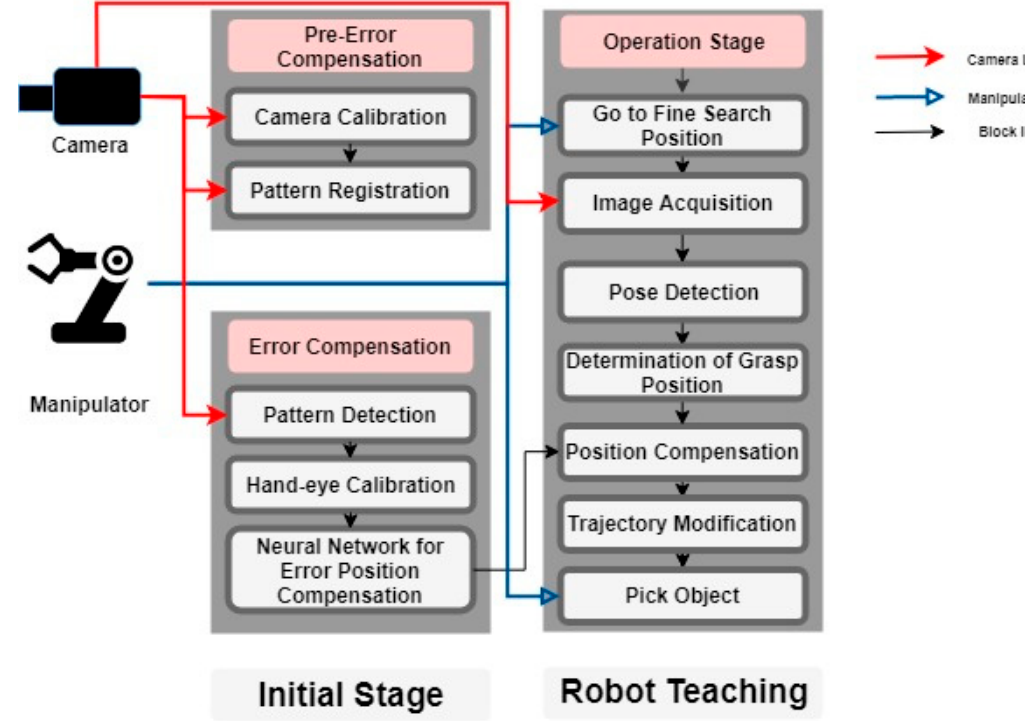
Figure 2. The overall architecture of proposed error compensation algorithm.